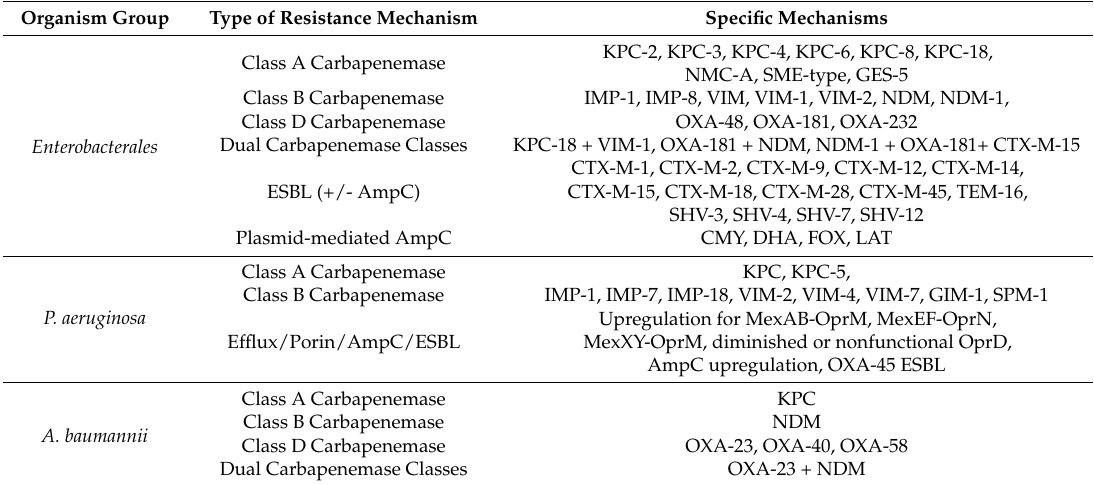
Table 1. Resistance mechanisms of organism